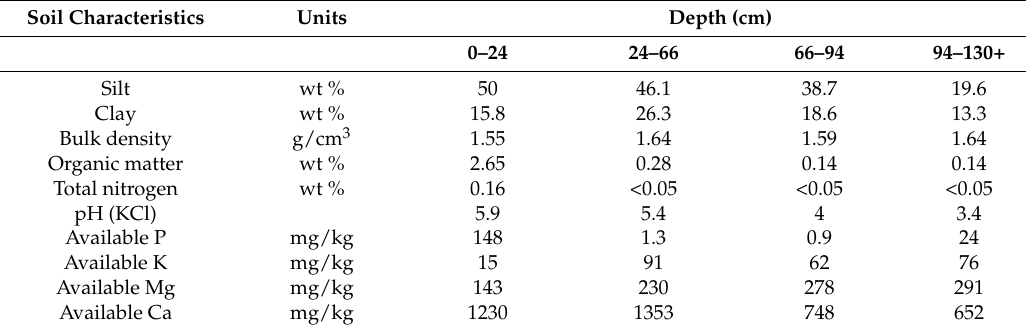
Table 1. The selected soil characteristics of the experimental site taken from Trnka et al.